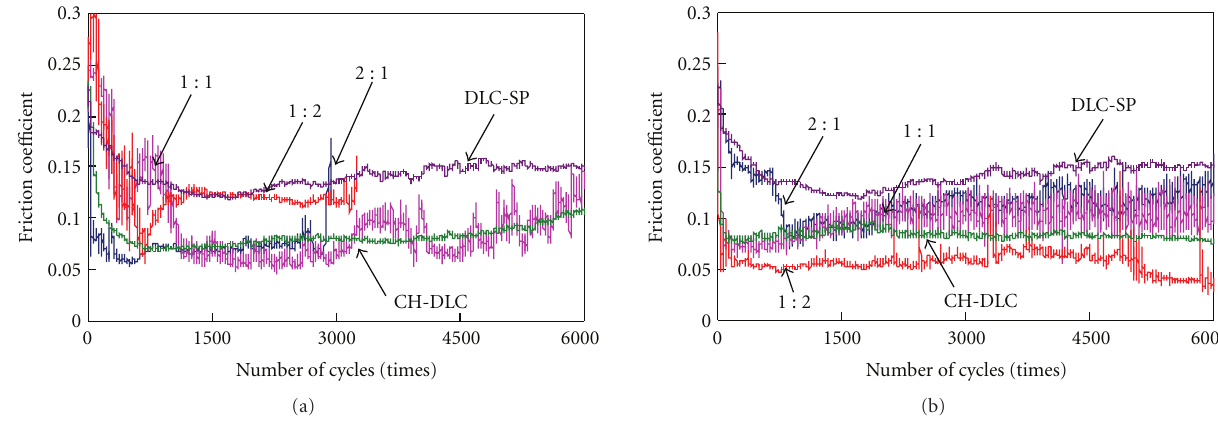
Figure 4: Changes in friction coe ffi cients under ambient air with bias voltage of (a) 0 kV (b) − 5kV. Table 3: Internal stress values of S-DLC films as a function of bias voltages and C/S flow-rate ratios. Sample no.